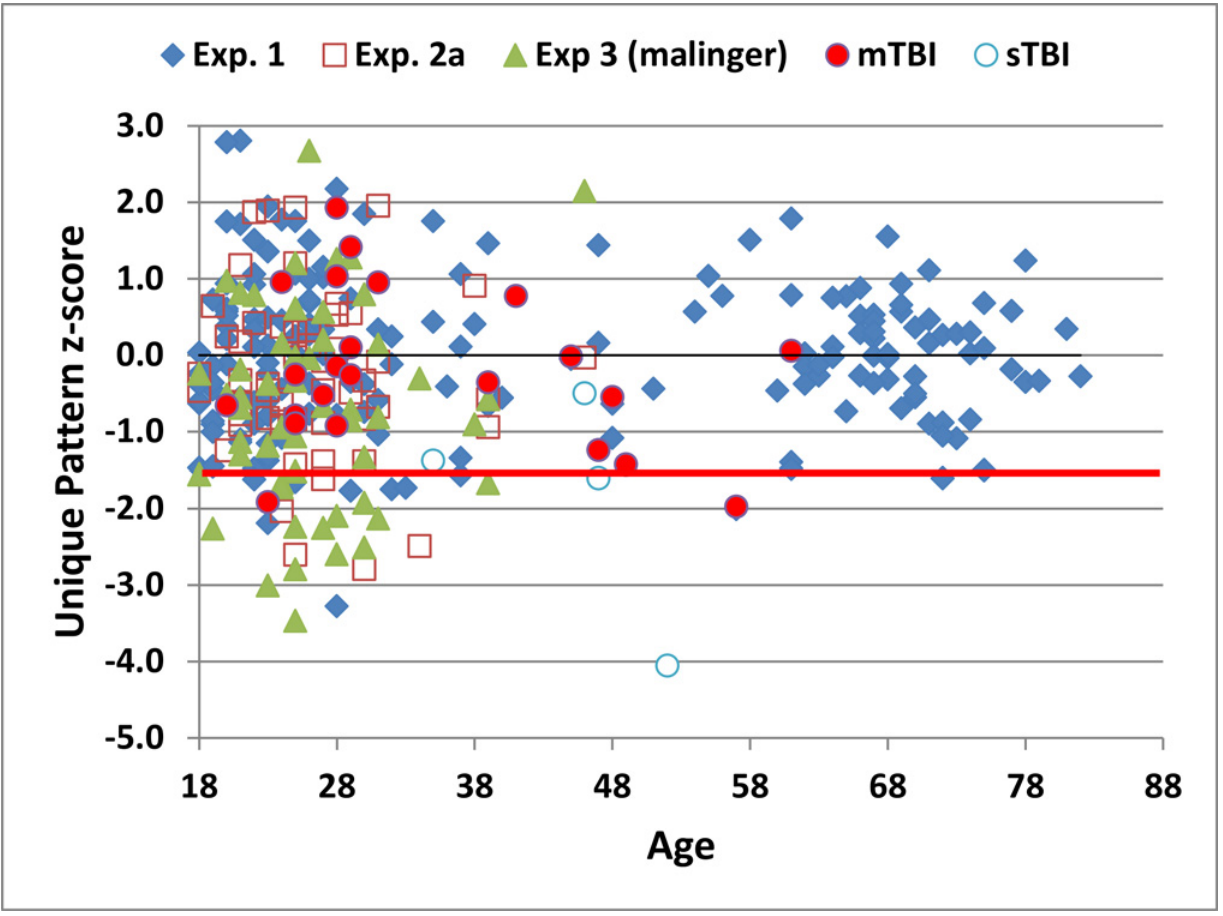
Fig 3. Unique pattern z-scores as a function of age. Z-scores showing the number of unique patterns produced from participants as a function of age after correction for the effects of age and computer use. The red line shows the p < 0.05 abnormality threshold as defined in Experiment